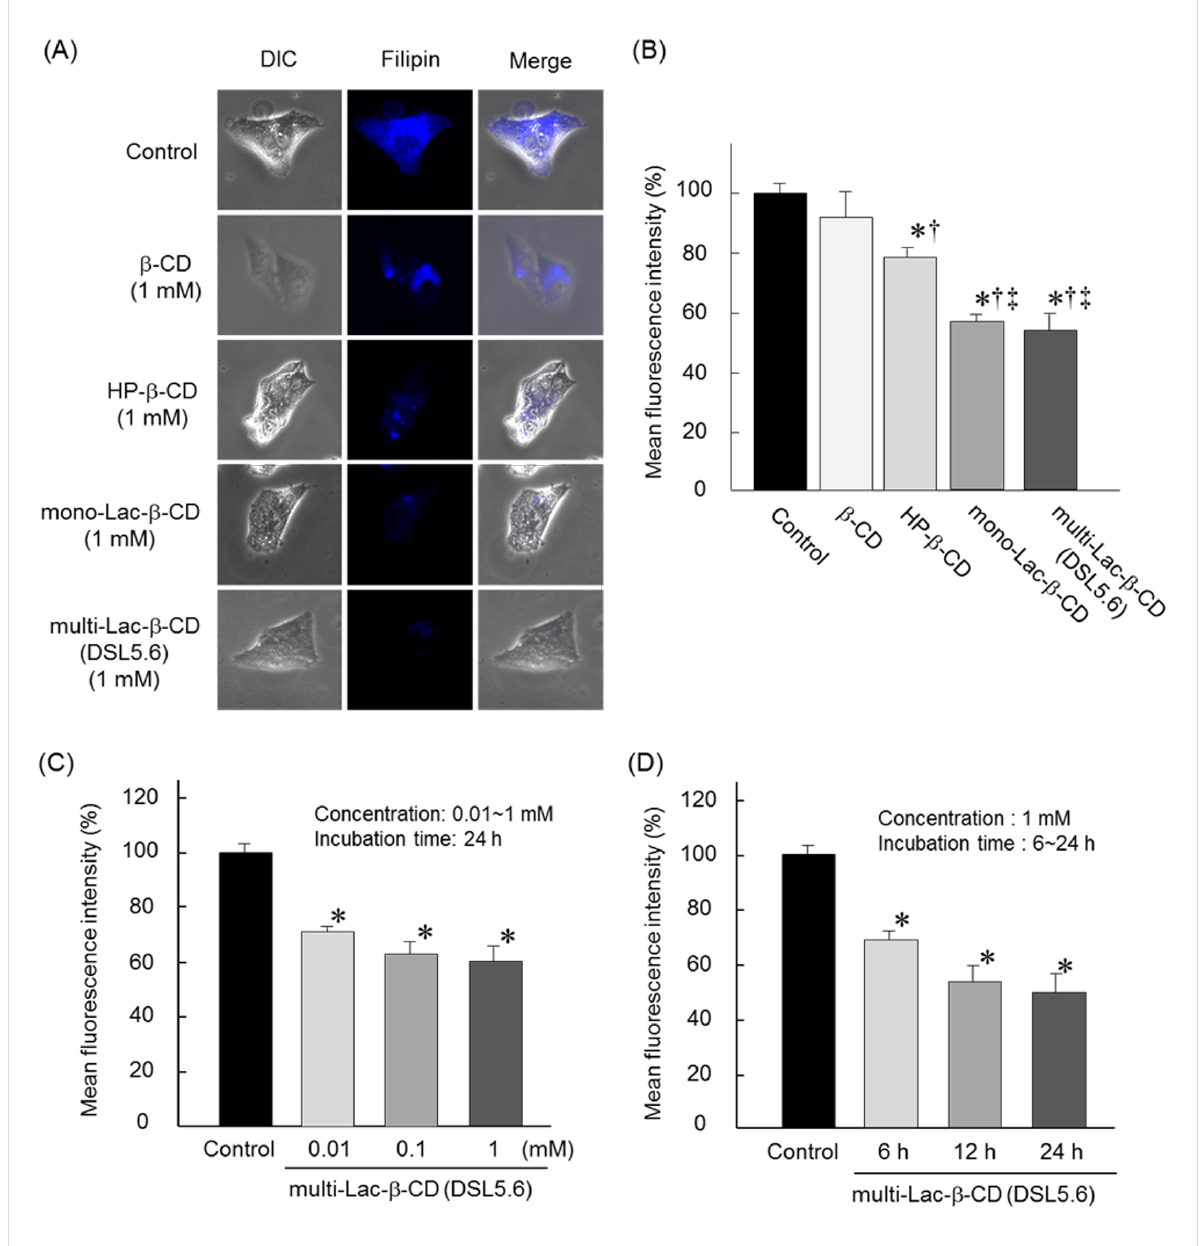
Figure 6: Intracellular distribution of cholesterol in NPC-like HepG2 cells. (A) NPC-like HepG2 cells (1 × 10 5 cells/35 mm dish) were treated with β -CD, HP- β -CD, mono-Lac- β -CD or multi-Lac- β -CD (DSL5.6) for 24 h at a concentration of 1 mM. (B) Fluorescence intensities of Filipin III in ten randomly selected cells were determined by the fluorescence microscope and BZ-II analyzer. (C) Effects of varying concentrations of multi-Lac- β -CD (DSL5.6) on cholesterol levels. (D) Effects of incubation time of multi-Lac- β -CD (DSL5.6) on cholesterol levels. Data represent mean ± S.E.M. of three experiments. * p < 0.05, compared with control. † p < 0.05, compared with β -CD. ‡ p < 0.05, compared with HP- β -CD.